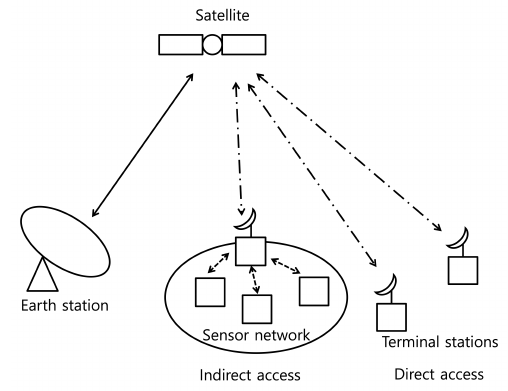
Figure 1. Satellite communication networks supporting Internet of Things